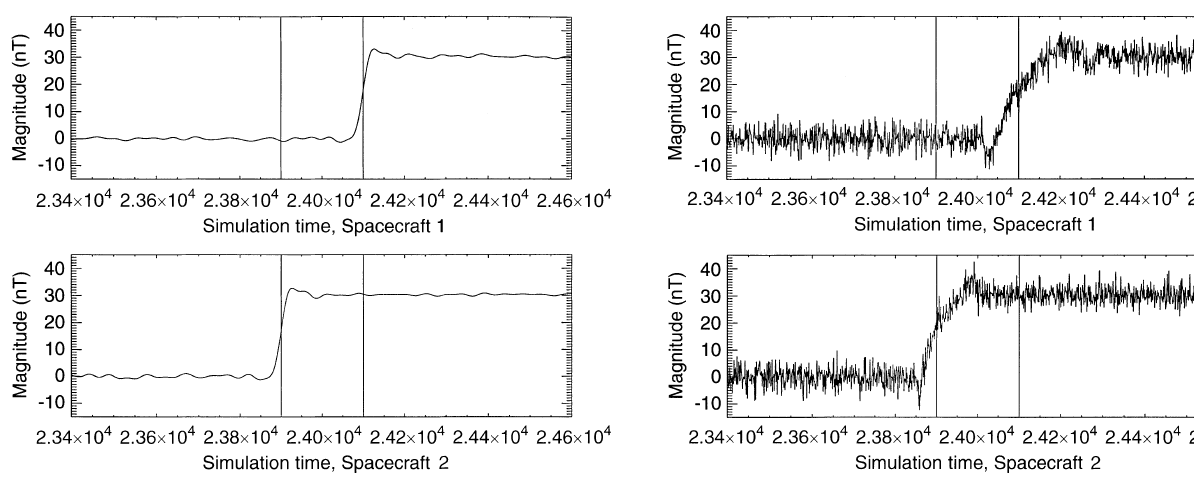
Fig. 8. The magnetic B ? field component as sampled by the spacecraft. The abscissa denotes the simulation time ~ t and the ordinate the corresponding magnetic field for the time evolving run. The samples of higher and lower simulation time are clipped, since they only represent noise